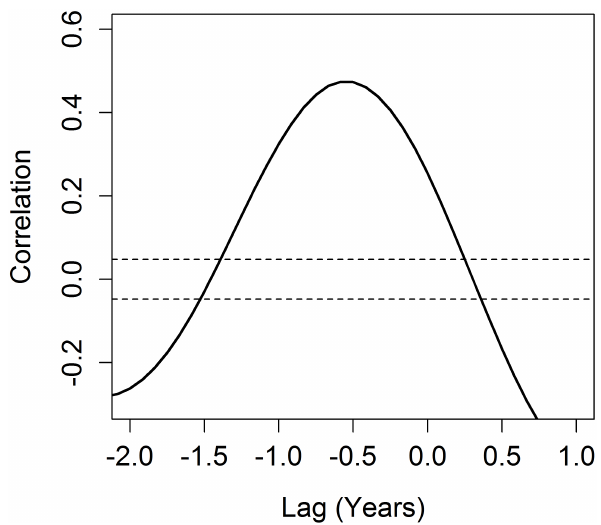
Fig. 4. Cross correlation between MEI and reconstruction from the six AMOI(ENSO) EOFs. The peak correlation value is 0.47 with MEI leading AMOI by 6 months. Dashed lines quantify 95% con- fidence intervals outside of which the null hypothesis of zero corre- lation is rejected.